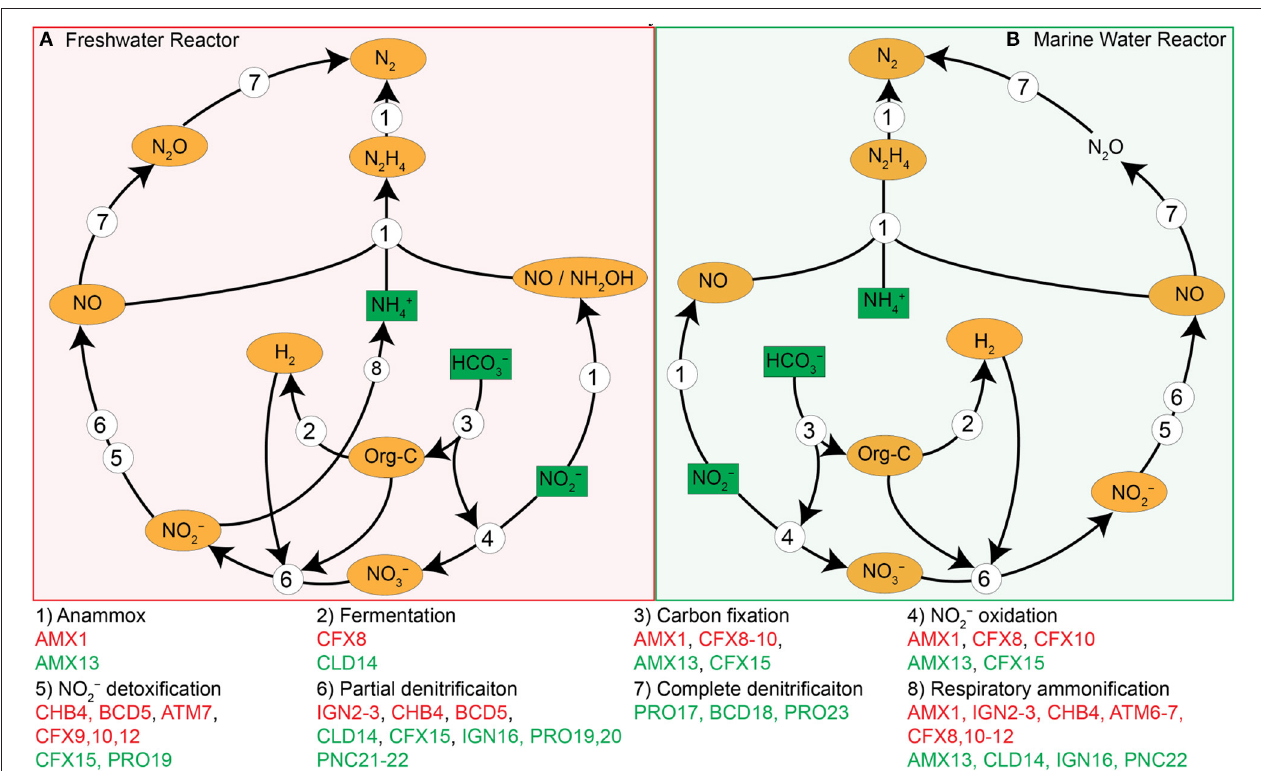
FIGURE 6 | Schematic overview of ecological model in freshwater ( A , red backdrop) and marine water anammox reactor ( B, green backdrop). Substrates (NH + 4 , NO − 2 , and HCO − 3 ) supplied in with the influent are indicated by a green box. Products and intermediates of the bacterial reactions are presented in orange oval. NH + 4 and NO − 2 were converted to N 2 gas by conventional anammox process. Part of NO − 2 is further oxidized to NO − 3 by anammox and some other mixotrophic bacteria (CFX8, CFX10, and CFX15) to gain reducing power for CO 2 fixation through Wood-Ljungdahl pathway. The produced NO − 3 can be reduced (to NO − 2 , NO, N 2 O, or N 2 ) via denitrification with either organic carbon (Org-C) or molecular hydrogen (H 2 ) as an electron